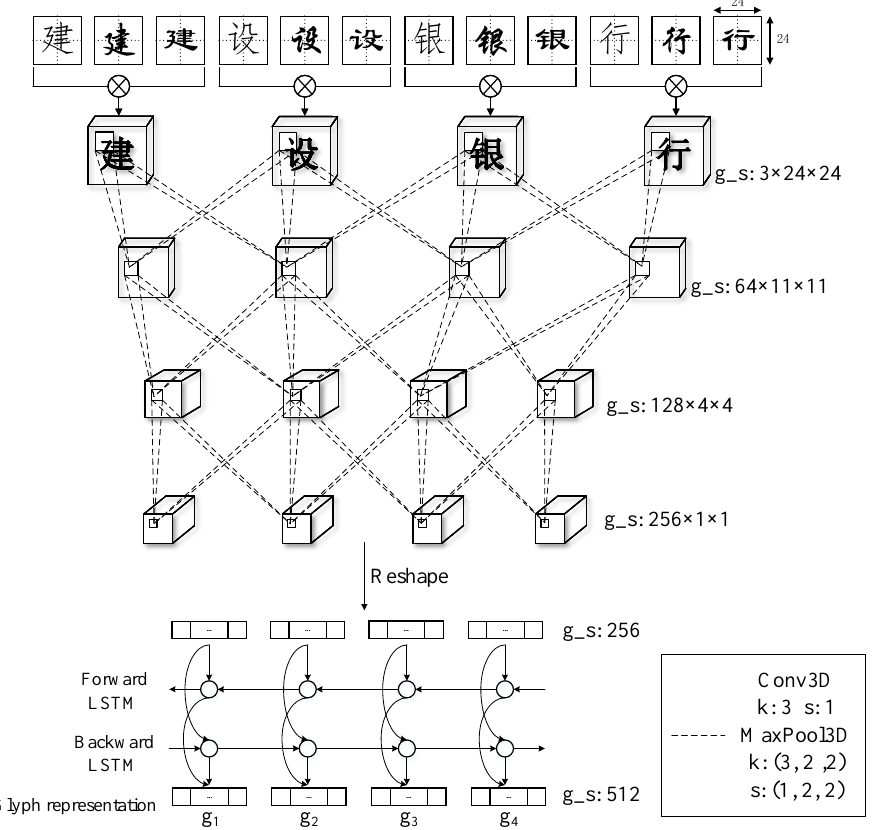
Figure 2. Architecture of CBHNN. “g_s” represents the tensor size of output from each network. “Conv3D”, “MaxPool3D”, “k” and “s”” stand for 3DCNN, 3D max-pooling, kernel size and